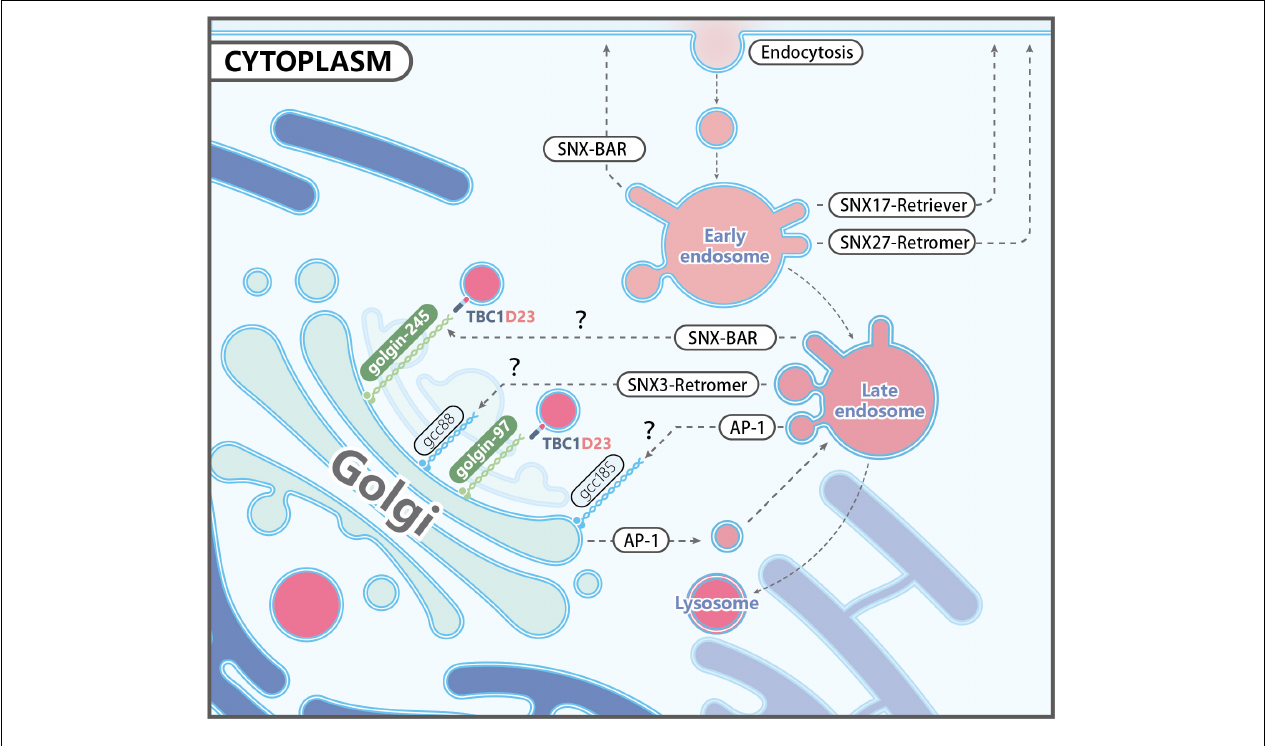
FIGURE 1 | Representative trafficking pathways of transmembrane proteins. Transmembrane receptors are internalized via endocytosis, and some of them are targeted to lysosomes as endosomes mature. Other receptors are recognized by specific coat proteins and sorted to the plasma membrane or the trans -Golgi network (TGN), thus evading degradation. Known protein complexes involved in endosome-to-plasma membrane trafficking include SNX17-retriver, SNX27-retromer, and SNX-BARs. Endosome-to-TGN transport depends on cargo recognition mediated by SNX3-retromer, SNX-BARs, or Clathrin/AP1. Other proteins mediating endosome-to-TGN trafficking, including other Adaptor Proteins, Rab9, TIP47, and PACS-1, are not shown for simplicity. The TGN-localized golgin proteins, such as golgin-97, golgin-245, GCC88, and GCC185, are capable of capturing distinct types of endosomal carriers, although the specificity and underlying mechanisms are largely unknown. TBC1D23 acts as an adapter by interacting with golgin-97 and golgin-245, and the WASH complex subunit FAM21 on endosomal vesicles. It should be noted that AP-1 is also found at the TGN, and mediates the bi-directional trafficking between endosomes and the